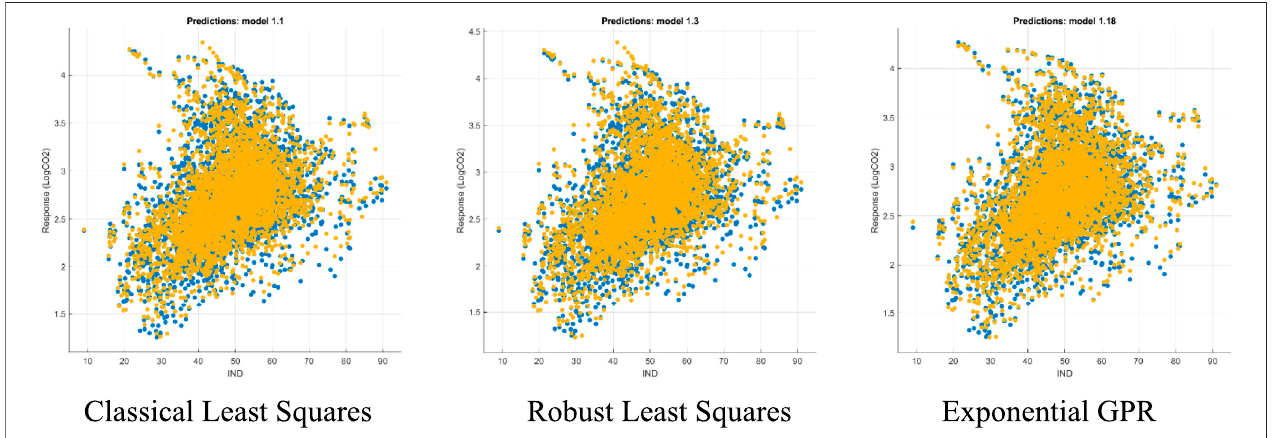
FIGURE 6 | Comparing actual and predicted CO 2 emissions against the industrialization of the selected models. Classical Least Squares, Robust Least Squares, ExponentialGPR.Notes:1)TheverticalaxisrepresentsthevalueofCO